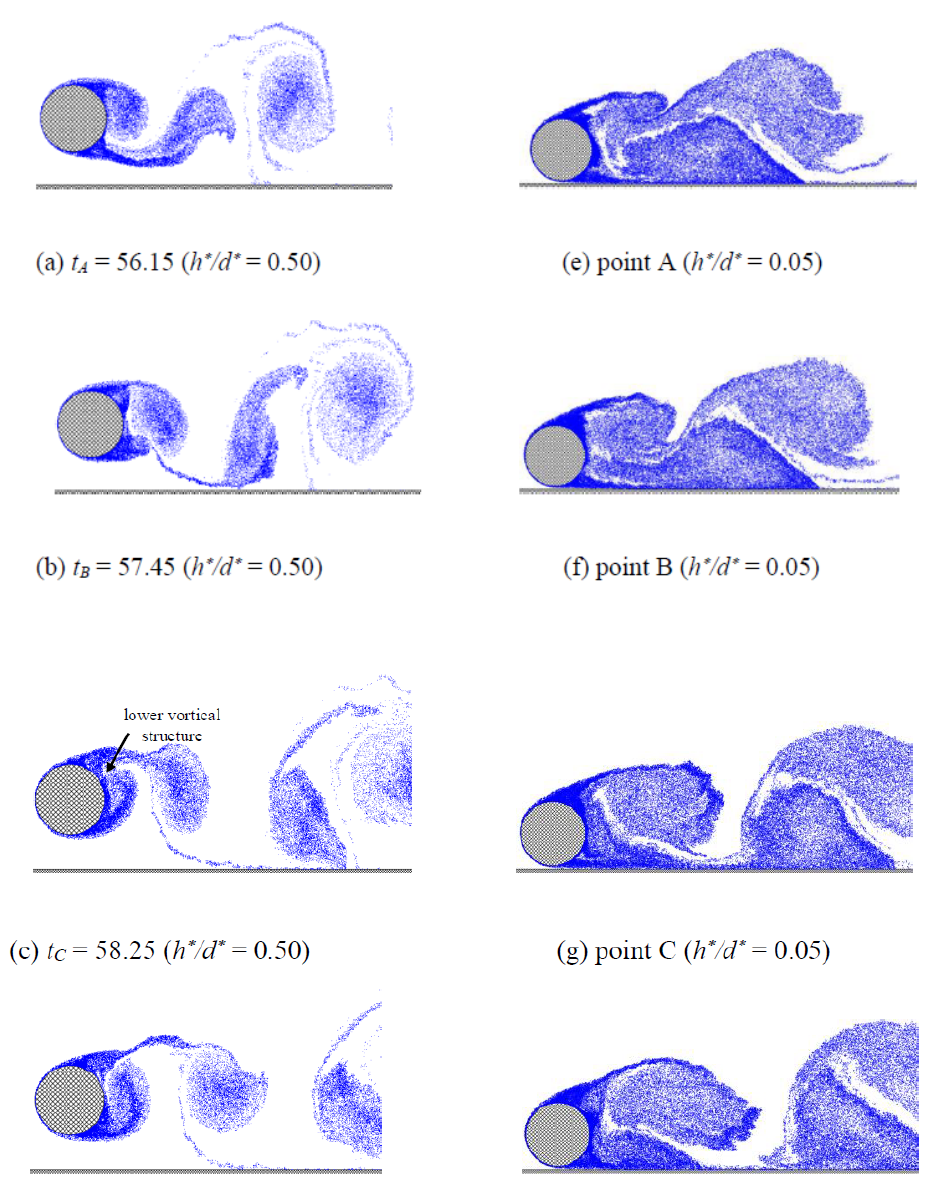
Figure 7. Near wake patterns for the circular cylinder in the vicinity of a moving wall ( ε * / d * = 0.000; Re = 1.0 × 10 5 ).